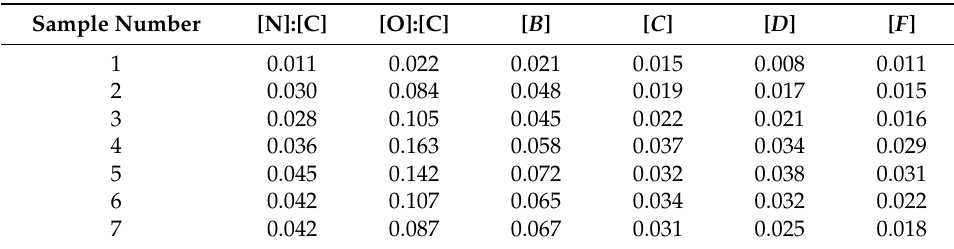
Table 5. Fractions of component peak